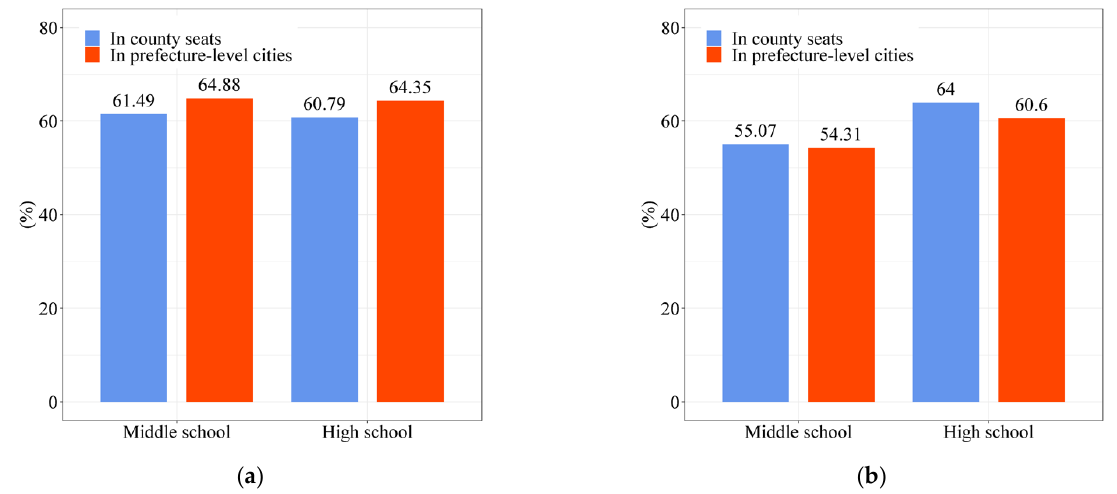
Figure 7. Rural residents’ satisfaction with the schools their children attend. ( a ) Rural residents’ satisfaction with the quality of teaching in their children’s schools; ( b ) rural residents’ satisfaction with the accommodation of the schools their children attend (Source: by the authors). In terms of medical services, according to statistics, the average number of beds in medical institutions per 1000 people in 81 sample counties is 5.5 per 1000 people. The average number of licensed physicians per 1000 people is 2.4 per 1000 people, both of which are lower than the intermediate level of the municipal districts of the prefecture- level cities (9.0 per 1000 people and 4.0 per 1000 people) to which these counties belong. The questionnaire survey of villagers shows that 36.4% of rural residents would choose to go to provincial and municipal hospitals for better medical care when suffering from a severe illness. As mentioned above, the county seat has gathered 48% of the counties’ population and is the first choice of more than half of rural residents with severe illnesses. The population served by hospitals in county seats is much larger than the permanent population, the mismatch between the supply and demand of medical resources in the county seat is apparent, and the quality of medical services needs to be improved. 4.2.2. The Township Assumes a Crucial Public Service Function With the continuous population exodus from rural areas, more and more rural chil- dren will study with their parents in the county seat or other locations outside the county. Many rural elementary schools are being abolished due to insufficient students to sustain their operations. The questionnaire survey of villagers shows that the proportion of rural children attending elementary school in townships is 51.19% in 81 sample counties. It has become a significant trend for rural children attending townships’ elementary schools. However, at this stage, the teaching facilities’ support and education service quality of China’s rural elementary schools still have apparent shortcomings. Figure 8 illustrates where rural residents think the township elementary school their children attend needs improvement. A total of 47,344 villagers interviewed have children attending elementary school in their township or neighboring townships, of which 50.63%,49.79%,40.65%, and 28.75% of them think the quality of teachers, teaching facilities, school meals, and board- ing conditions need improvement.